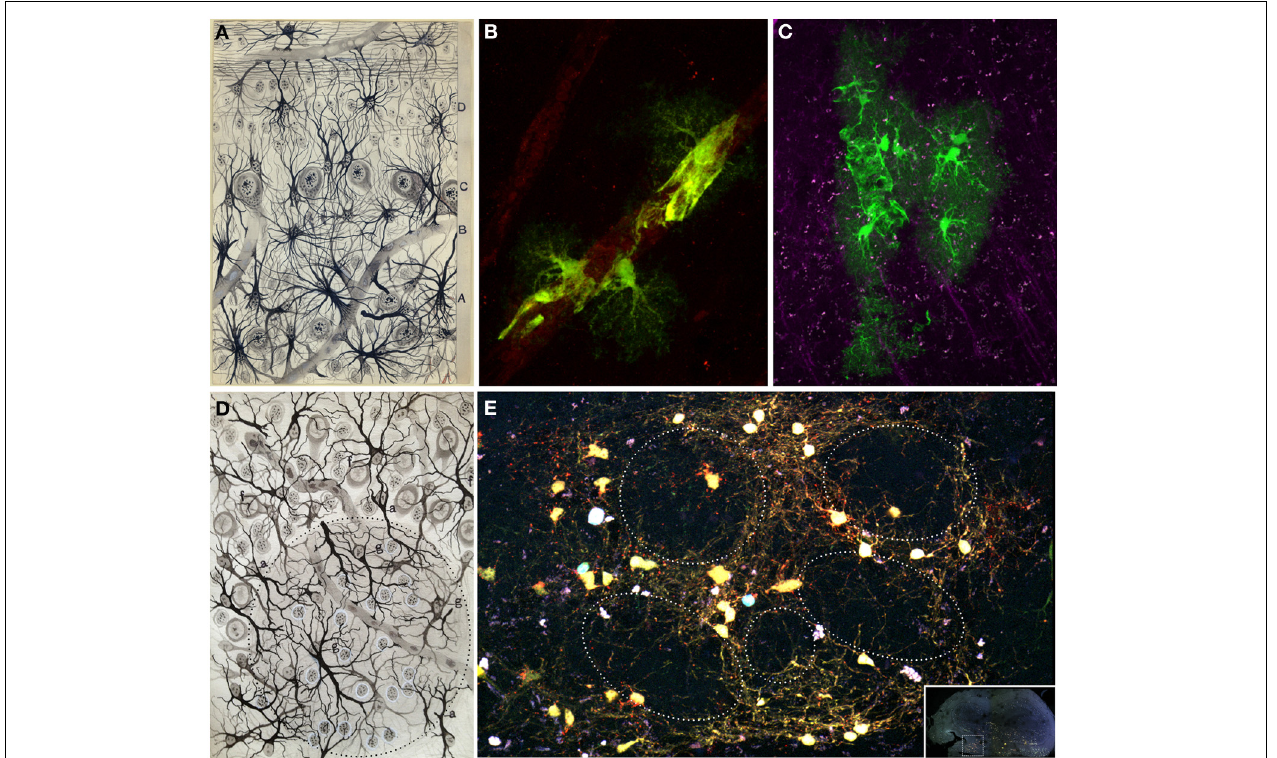
FIGURE 9 | Glial cells. (A) Original Fernando de Castro drawing of human olfactory bulb stained with Cajal’s gold chloride sublimate method. Superficial substratum of the molecular layer with numerous cephalopodic cells (A) , deep substratum (B) , mitral cell layer (C) , grains layer (D) (De Castro, 1920). (B,C) Processes of protoplasmic astrocytes arranged around a blood vessel labeled after in utero electroporation of the Star Track plasmid mix (García-Marqués and López-Mascaraque, 2013) into the lateral ventricles. These perivascular end feet are represented in the olfactory bulb (A) by Fernando de Castro. Panel (B) modified from Martín-López et al. (2013) and panel (C) were taken by Eduardo